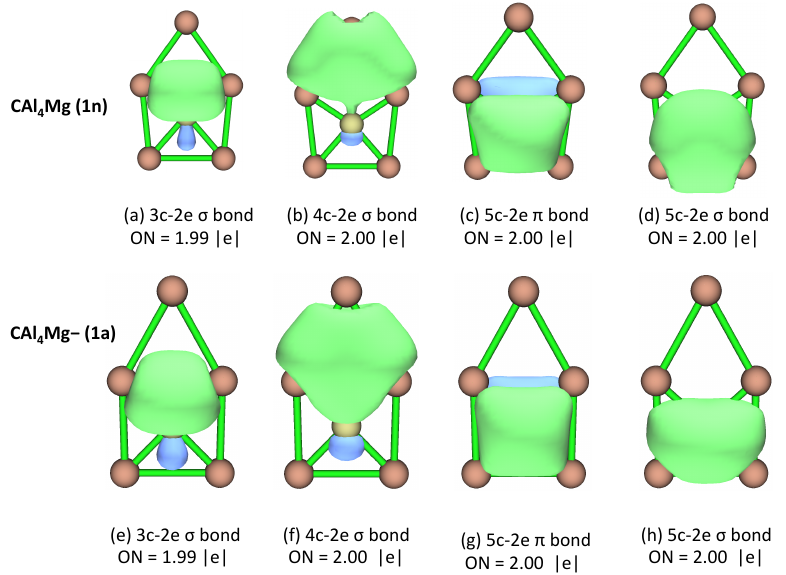
− ( 1a ) obtained at the 1n ) and CAl 4 Mg ( 4 Mg